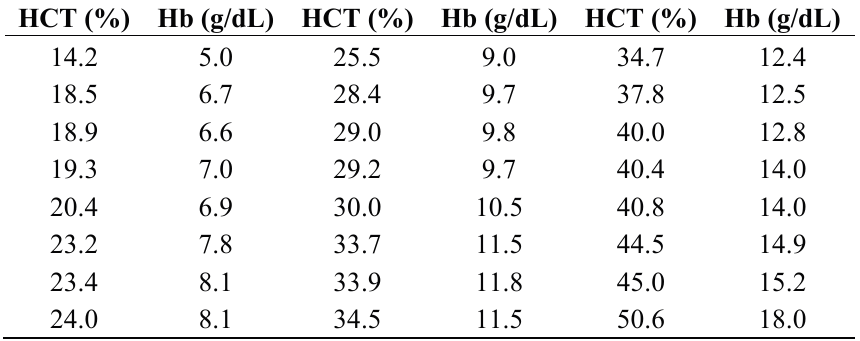
Table 1. Twenty four blood samples obtained in Hospital Clínic from four random hospitalized patients. Blood samples were obtained diluting RBCs in different volumes of blood plasma. Hematocrit (HCT (%)) and hemoglobin (Hb (g/dL)) values for the different blood samples were obtained by means of a complete blood count